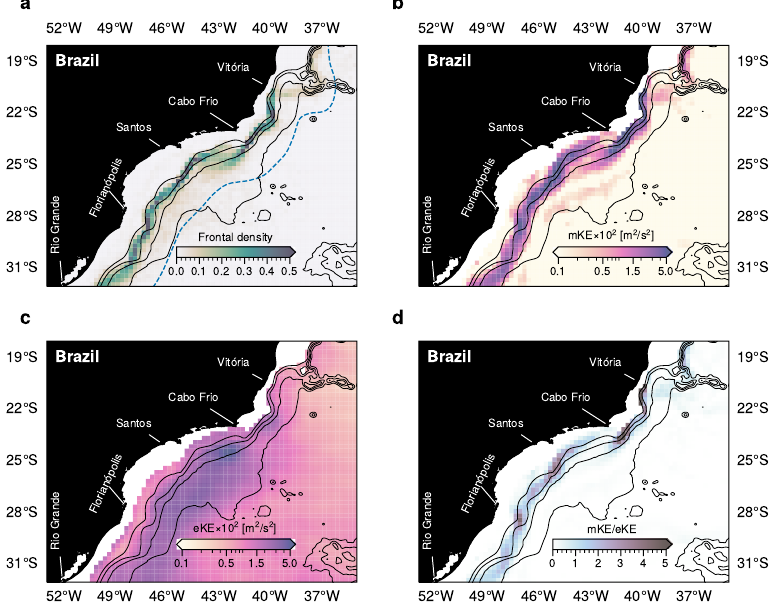
Figure 3. ( a ) Brazil Current frontal density defined by the probability of finding the monthly mean contour h (cid:48) = 0.05 m in each 0.25 ◦ × 0.25 ◦ pixel. ( b ) Mean surface kinetic energy ( MKE ) from the 28-year mean ADT. ( c ) Surface eddy kinetic energy ( EKE ) from 28 years of sea-level anomalies. ( d ) Ratio between mean and eddy kinetic energy, highlighting regions where the mean Brazil Current is stronger than its variability (dark purple) and regions dominated by mesoscale variability (white). The dashed blue line in ( a ) is the Brazil Current MDT front shifted 200-km due east; the Brazil Current region is defined as the area west of this curve. Solid black lines in ( a , c ) depict the 200, 1000, 2000 and 3000-m